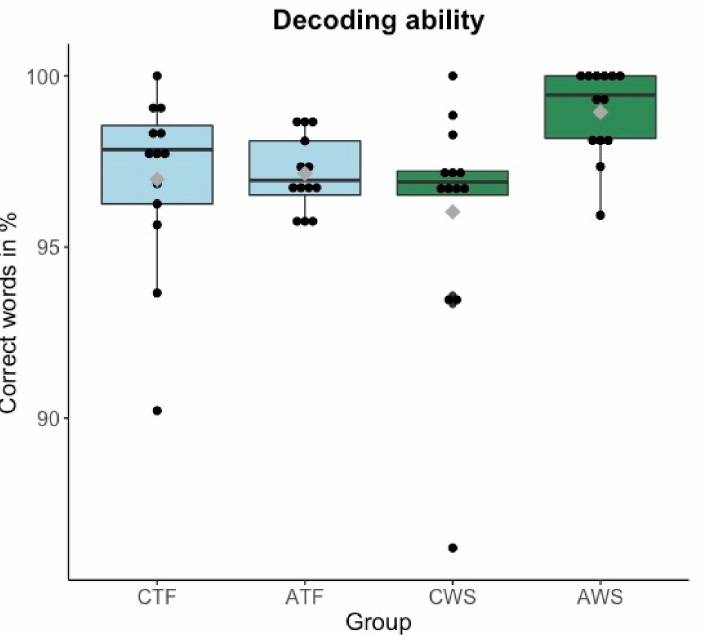
Figure 2. Boxplots of decoding ability-percentage of correctly produced words per group in a one- minute reading period (y-axis). Each dot represents each participant’s reading accuracy in percent. Mean values per group are visualized with a gray diamond within each boxplot. CTF: children with typically fluent speech, ATF: adolescents with typically fluent speech, CWS: children who stutter, AWS: adolescents who